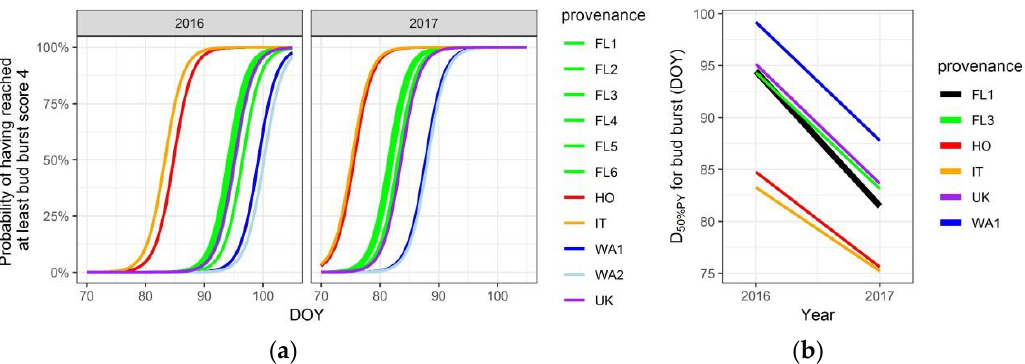
Figure 2. Modeled timing of bud burst for the different provenances in 2016 and 2017: ( a ) Modeled probability of having reached at least bud burst score 4; ( b ) D 50% PY values for the provenances ( P ) with a significant interaction term in the model statistics, for the years ( Y ) 2016 and 2017. D 50% PY values indicate the modeled day of the year (DOY) when half of the plants of a provenance attain a bud burst score of at least four.